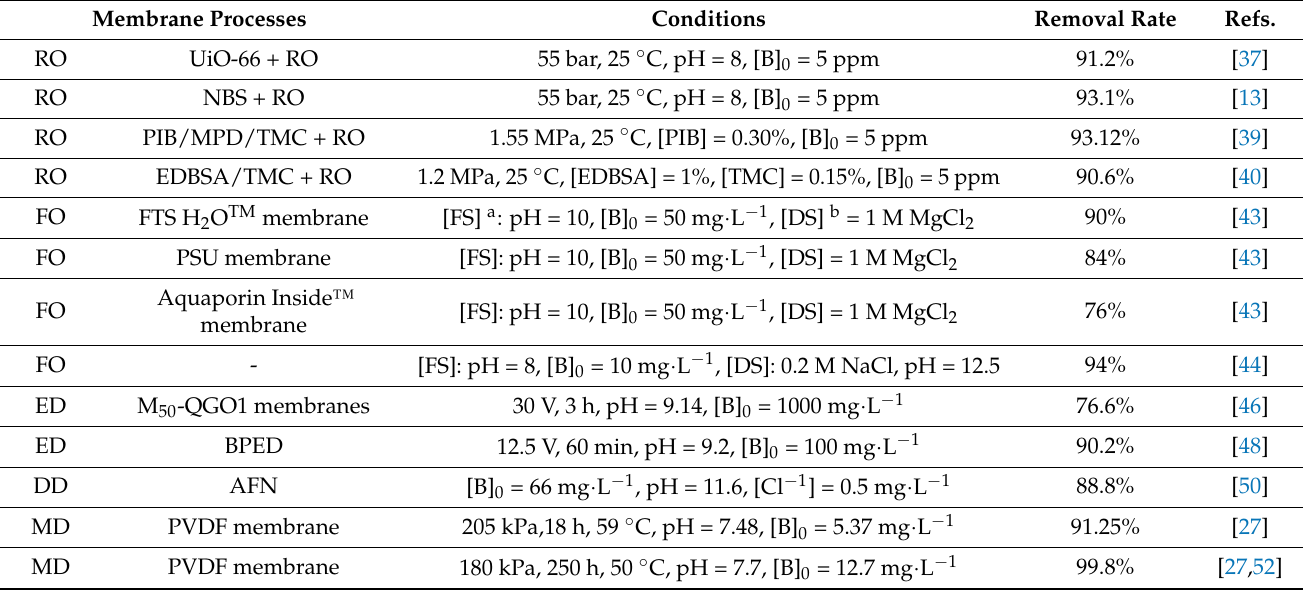
Table 6. Boron removal performances of different membrane